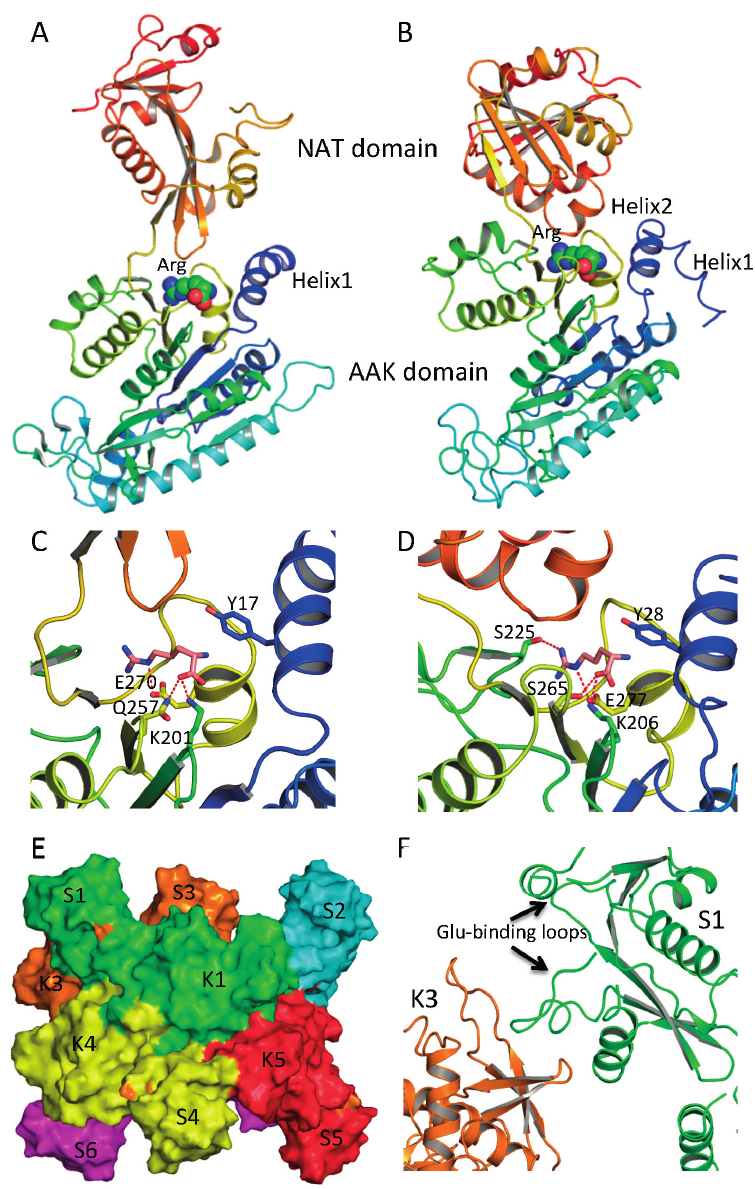
Figure 5. Arginine binding site and conformational changes. ( A ) Ribbon diagram of subunit structure of ngNAGS in the presence of arginine; ( B ) Ribbon diagram of subunit structure of mmNAGS/K in the presence of arginine. Arginine is shown in space filling model; ( C ) The details of arginine binding site of ngNAGS; ( D ) The details of arginine binding site of mmNAGS/K. The arginine and key residues involved in binding arginine are shown in sticks; ( E ) Simplified model of quaternary structure in the presence of arginine; and ( F ) The K3-S1 interface of ngNAGS in the presence of